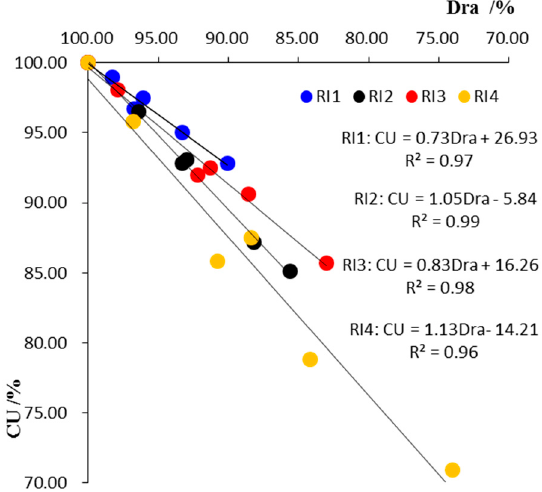
Figure 5. Relationship between Dra and CU under different fresh-saline alternating irrigation models.